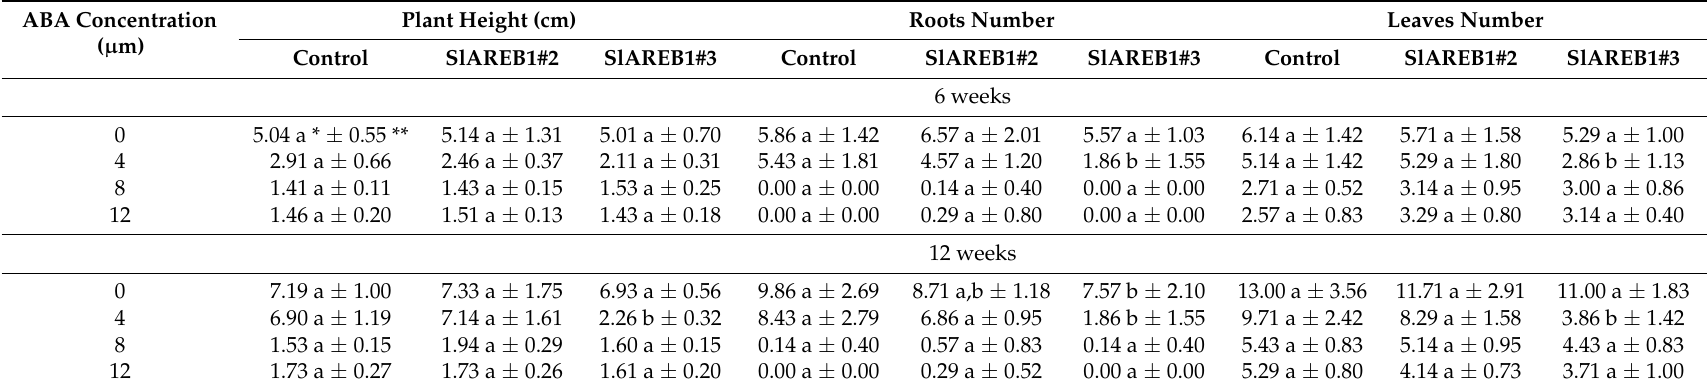
Table 3. Effects of ABA concentration on plant height, roots number and leaves number of in vitro conserved microshoots of negative control, SlAREB1#2, SlAREB1#3 transgenic tomato plants after 6 and 12 weeks of